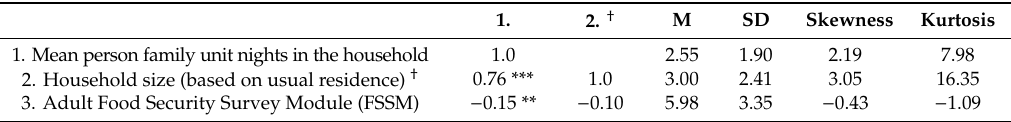
Table 3. Spearman correlations and associated descriptive statistics for mean person nights, household composition, and food security